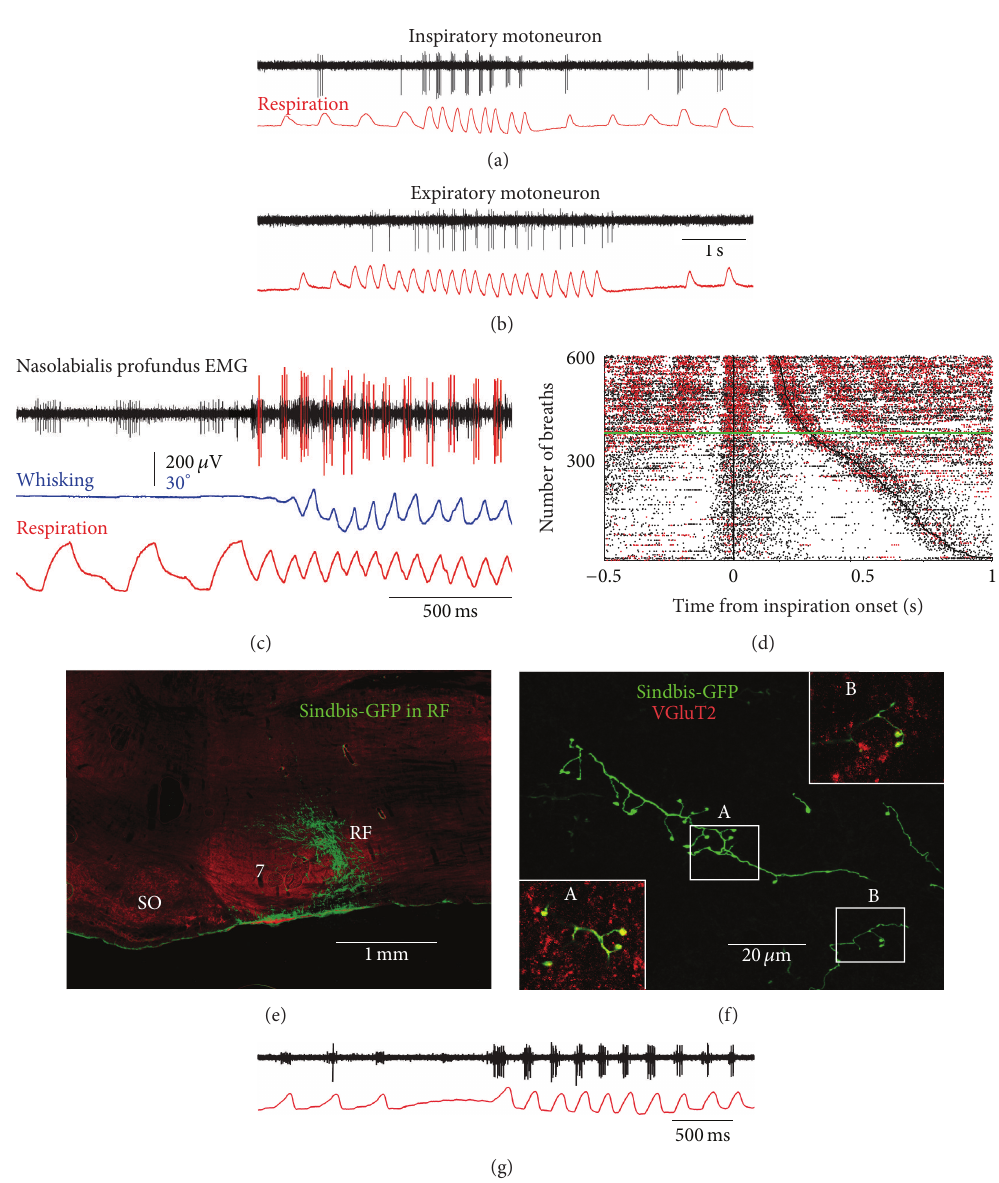
Figure 3: Facial motoneurons and sniffing. (a, b) Recording of facial motoneurons in alert head-restrained rats reveals respiration-related cells that fire preferentially during sniffing. (c) Electromyographic recording of NLP motor units during basal respiration and sniffing. Note that the small unit is active during both basal respiration and sniffing, while the large unit only fires during sniffing. (d) Raster plots of the activity of NLP motor units relative to the onset of inspiration (black lines). Black and red dots represent spikes of the small and large motor units shown in (c), respectively. Individual breaths are ordered by the duration of the breath. The green line indicates the transition between basal respiration and sniffing. Note that the small unit is active during inspiration at all breathing frequencies, while the large unit is preferentially active during sniffing. (e) Sindbis-GFP injection in the retrofacial region leads to anterograde labeling in the facial nucleus. (f) Confocal microscopy reveals a majority of labeled boutons that are immunopositive for type 2 vesicular glutamate transporter (VGluT2). Framed areas A and B are enlarged in the corresponding inserts. (g) Example of respiration-related neurons of the retrofacial region that are principally recruited during sniffing. Data in panels (a) to (d) are adapted from [20], while data in panels (e) to (g) are unpublished results.